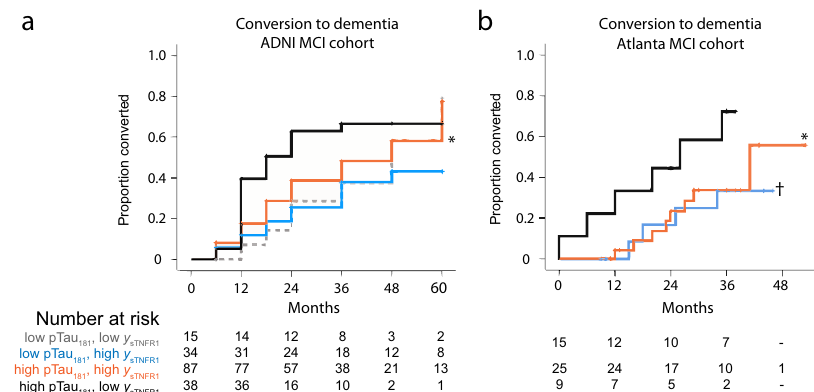
Fig. 4 Mild cognitive impairment (MCI) conversion in the ADNI and an Atlanta-based MCI cohorts. Conversion to dementia diagnosis based on the same p-Tau 181 levels and a regression-based prediction of sTNFR1 score ( y sTNFR1 ) reproduced the prognostic pro fi les from ADNI ( a ) in the replication cohort ( b n = 49). *Lower conversion compared to those with p-Tau 181 ≥ 24.1 pg/mL but low y sTNFR1 ( p = 0.049 in ADNI and p = 0.038 in the Atlanta cohort). † Two subgroups with p- Tau 181 < 24.1 were combined due to small numbers, p = 0.068 vs. high p-Tau 181 and low y sTNFR1 . Source data are provided as a Source Data fi le. Table 4 MCI participants in replication cohort ( n =